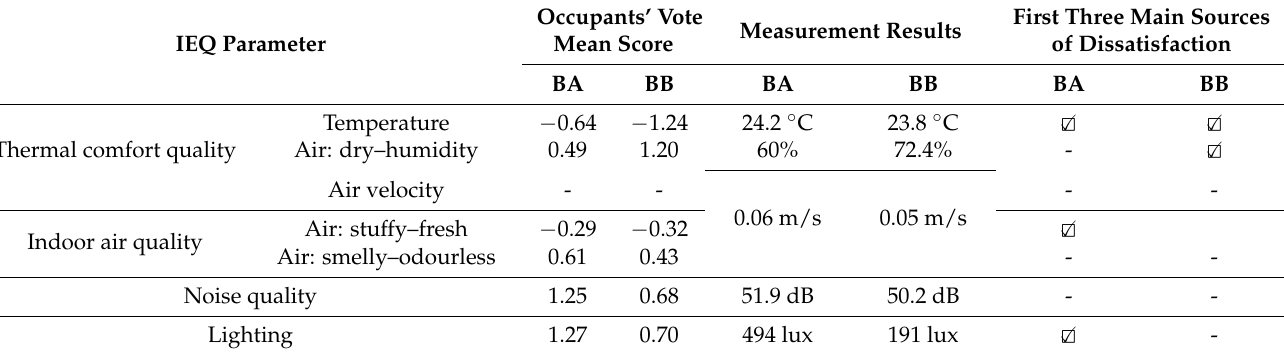
Table 6. Summary of results from measurement and survey of IEQ